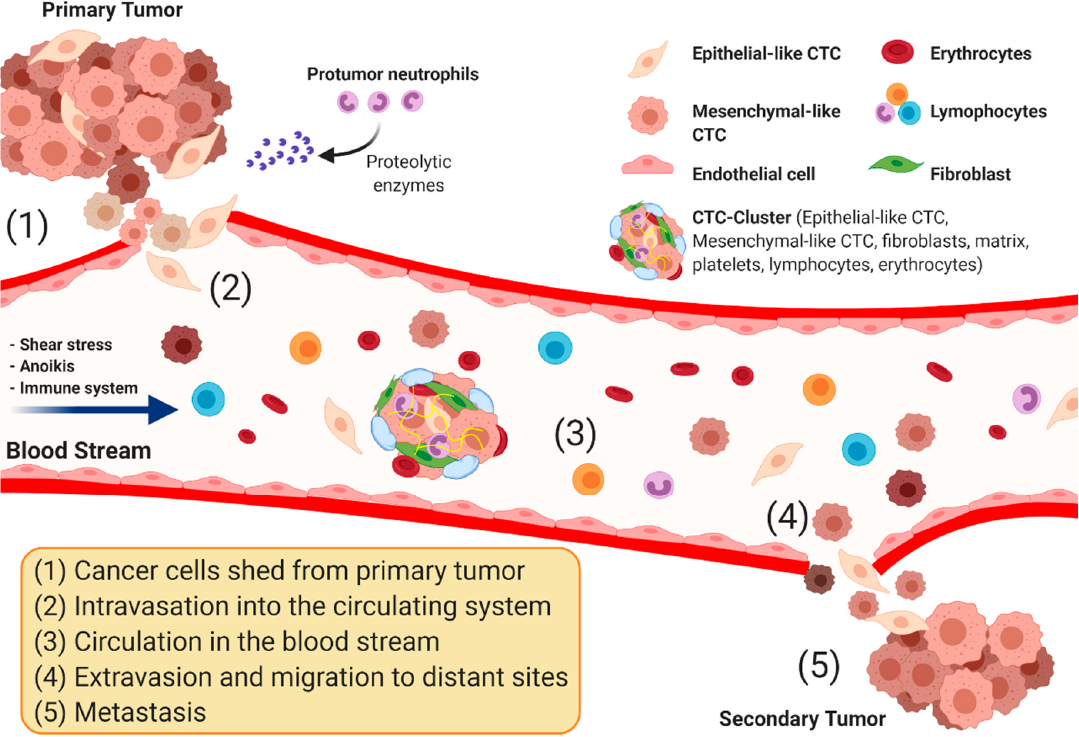
Figure 1. Schematic representation of circulating tumor cells (CTCs) detaching from primary tumor, intravasating into the bloodstream, and circulating to colonize distant organs after extravasating where they create secondary metastasis. Essentially, CTCs undergo epithelial-to-mesenchymal transmission (EMT), where cancerous epithelial cells lose their cell-to-cell contact and develop a more motile and less differentiated mesenchymal phenotype. In addition, infiltrating protumor neutrophils secrete proteolytic enzyme (e.g., matrix metallopeptidase 9 (MMP-9)) to aid CTCs in entering the bloodstream. In the bloodstream, these disseminating cells must overcome blood shear stress, anoikis and immune system response. Once reaching the distant cite, CTCs revert back to their epithelial phenotype and grow into secondary metastasis. CTCs can exist in the form of single cells or cell clusters which has increased metastatic potential. CTCs encompass more of the clonal populations in a tumor, they give a complete picture of tumor composition and how it changes overtime. They can be distinguished from other types of cells circulating in the blood through their differential expression of EMT biomarkers such as epithelial cell adhesion molecules (EpCAM) and Cytokeratin (CK). Figure created with Biorender.com.